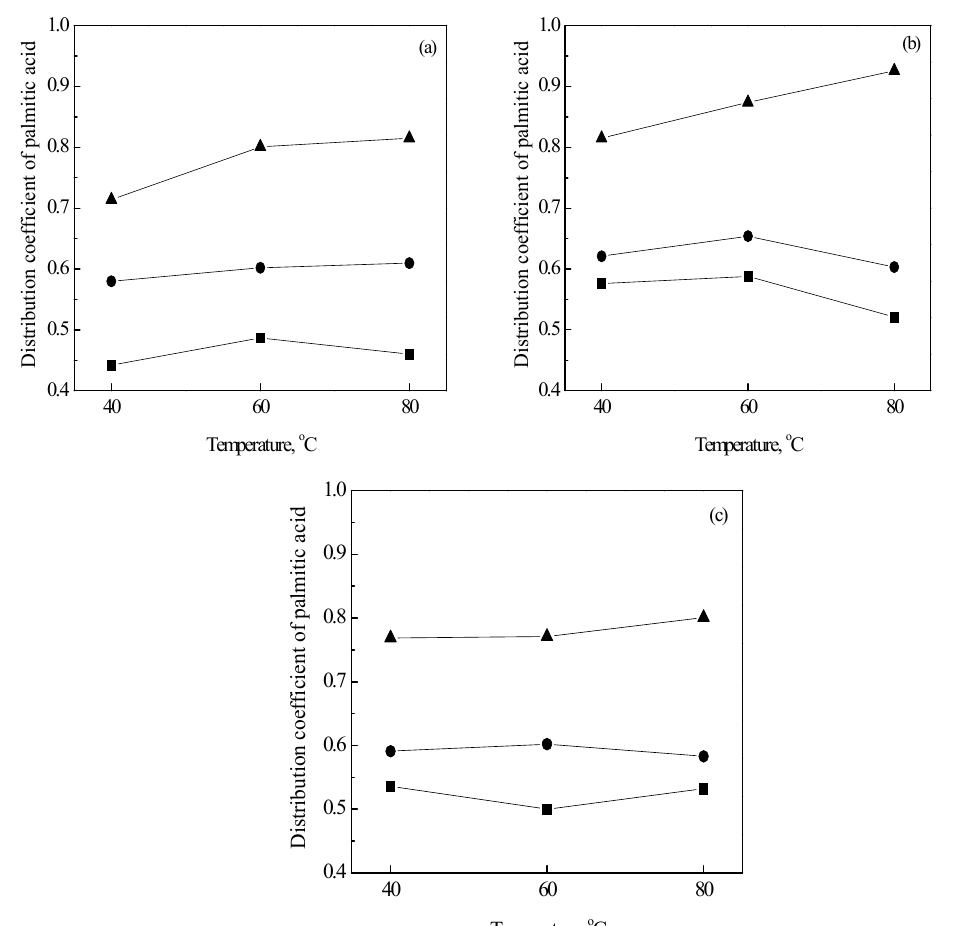
Figure 3. Distribution coefficient of palmitic acid as a function of temperature, palm oil to solvent mass ratios: ( ■ ) 2:1, ( ● ) 1:1, ( ▲ ) 1:2, and different palmitic acid contents in palm oil: ( a ) 2% mass, ( b ) 5% mass, ( c ) 8% mass.